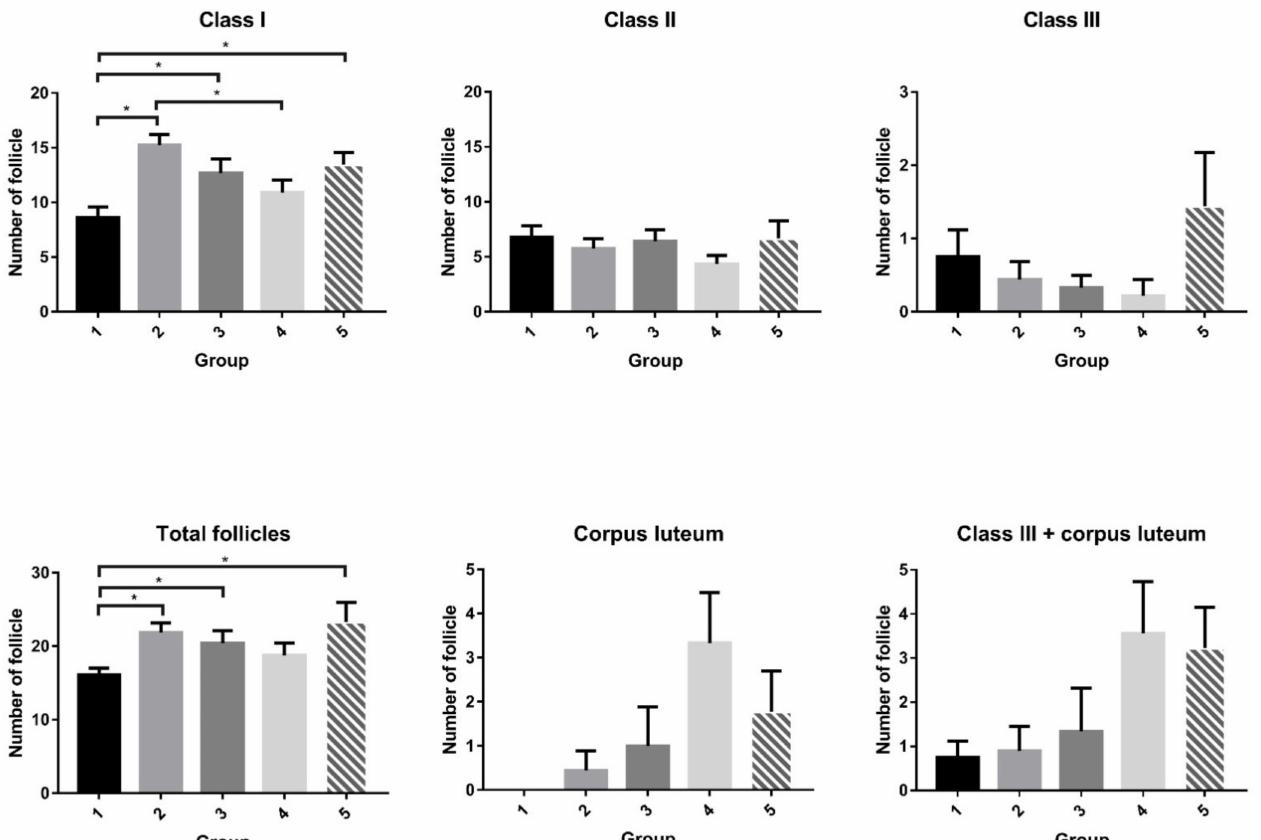
Figure 2. Number of follicles of each class in rats. In the ovary, the number of smaller follicles differed significantly among the groups ( p = 0.007). There were more smaller follicles in most groups of rats that received FSH injections (groups G2, G3, and G5), regardless of injection frequency and site, than in the negative control (group G1). Although the ovarian follicle patterns of large- (class III) and medium- (class II) sized follicles showed no relationship to injection frequency or site, the total number of follicles differed significantly among the groups ( p = 0.041). The rats that received abdominal (G2) or vaginal (G3) injections of 1 IU rhFSH or vaginal (G5) injection of 4 IU rhFSH had more follicles than the controls. In addition, the number of corpora lutea was borderline different among the groups ( p = 0.064), and the rats that received abdominal injections of 4 IU rhFSH (G4) had significantly more corpora lutea than the control rats. Moreover, there was a trend toward an increasing number of large follicles and corpora lutea in rats that received abdominal (G4) or vaginal (G5) s.c. injections of 4 IU rhFSH. G1: abdominal s.c. injection of normal saline twice daily for 4 days (days 1 to 4); G2: abdominal s.c. injection of rhFSH (1 IU) twice daily for 4 days (days 1 to 4); G3: vaginal s.c. injection of rhFSH (1 IU) twice daily for 4 days (days 1 to 4); G4: abdominal s.c. injection of rhFSH (4 IU) every other day (2 injections) (days 1 & 3); G5: vaginal s.c. injection of rhFSH (4 IU) every other day (2 injections) (days 1 & 3). * p <